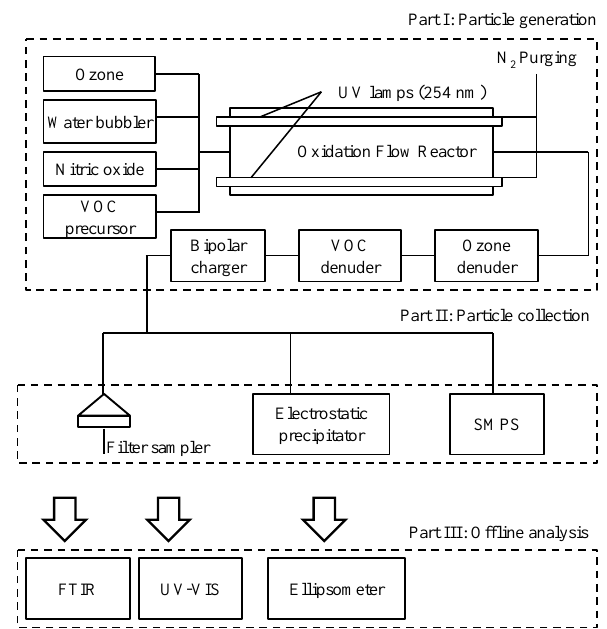
Figure 1. Schematic diagram of experimental apparatus. (I) Produc- tion of secondary organic material in aerosol form. (II) Sampling of particles onto a Teflon filter and growth of a thin film by electrostatic precipitation of particles onto a silicon substrate. (III) Fourier trans- form infrared spectroscopy (FTIR), ultraviolet–visible spectroscopy (UV–VIS), and spectroscopic ellipsometry of collected secondary organic